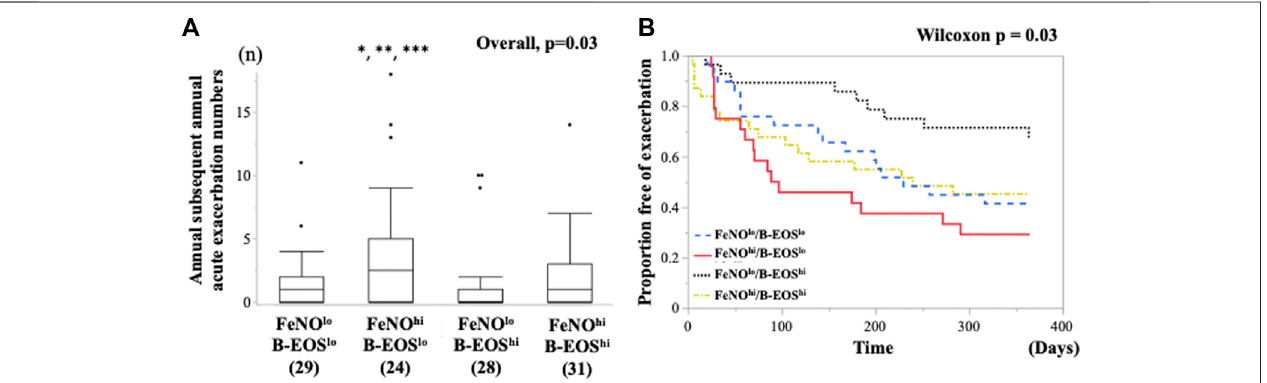
FIGURE2| Comparisonofthefutureriskofasthmaexacerbationsaftertheentrybetweenthetype2biomarker-classi fi edsubgroups. (A) Differencesinthenumber of annual subsequent asthma exacerbation after the entry among the subgroups classi fi ed by FeNO and B-EOS cutoff values for detection of sputum eosinophilia. Horizontal bars represent median. *vs. Low FeNO, High-b-EOS, p = 0.006; **vs. Low FeNO, Low-b-EOS, p = 0.01; ***vs. High FeNO, High-b-EOS, p = 0.04. (B) Kaplan – Meieranalysisforasthmaexacerbation-free timeaftertheentryamongthepredominanttype 2in fl ammationsubgroups.GeneralizedWilcoxon, p =0.048, Log Rank, p = 0.07. B-EOS, blood eosinophils; AE, asthma exacerbation.